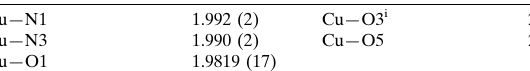
Selected bond lengths (A˚ ).